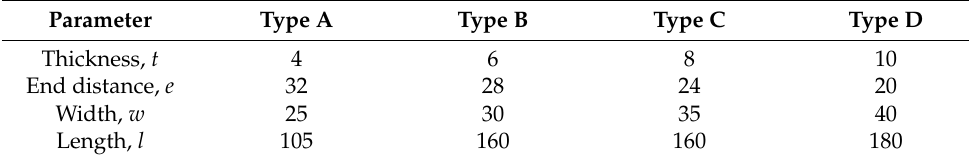
Table 2. Geometry parameters of the different sample types (dimensions are in mm).